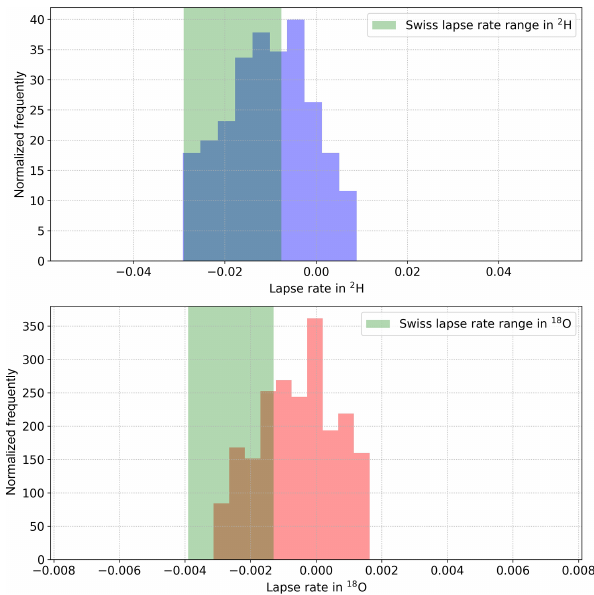
Figure 9. Histogram showing the posterior distribution of the iso- tope lapse rate parameter in δ 2 H and δ 18 O. The green region shows the confidence bounds (significant at α = 0 . 01) of the lapse rate computed over Switzerland by using inverse variance-weighted re- gression. The limits of the prior distribution of the isotopic lapse rates correspond to the limits of the x axis. The slope of the iso- topic ratio when plotted against elevation for the Swiss-wide data is shown in Fig. 3 of Beria et al.